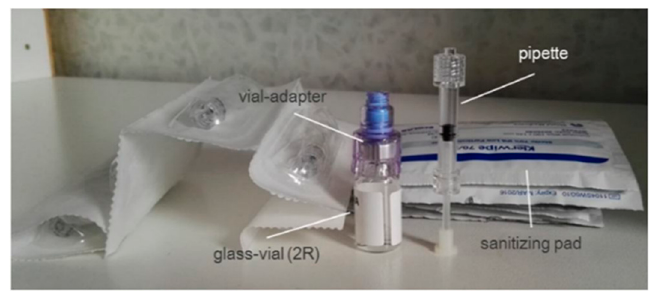
Figure 3. Oxervate ® administration kit.